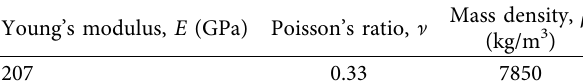
Figure 2: Geometry model of a rail track. (a) Cross section and (b) 3D geometry. Table 1: Material property of the